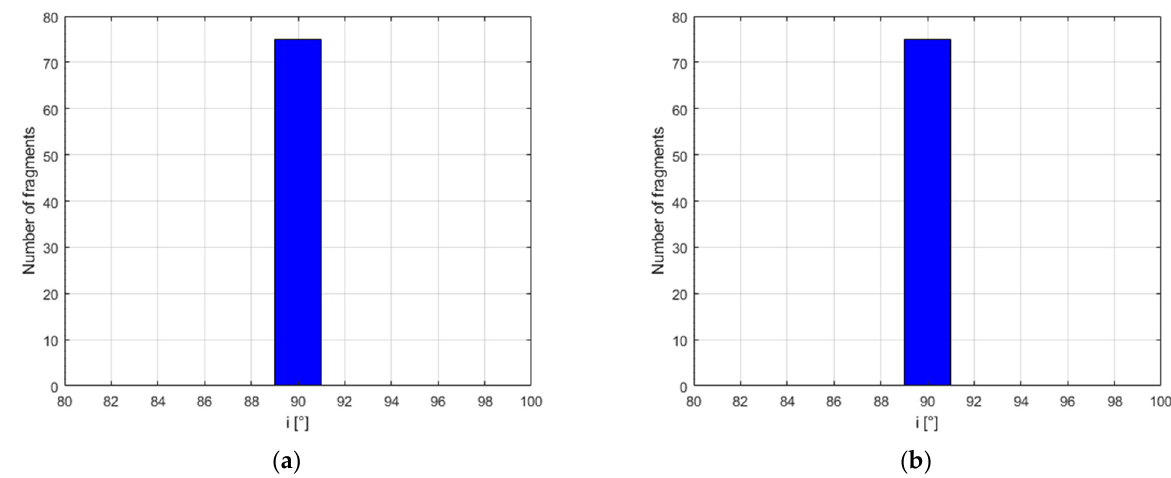
Figure 13. Distribution of reference fragments in plane i sin ( Ω )-i cos ( Ω ) for second test case.